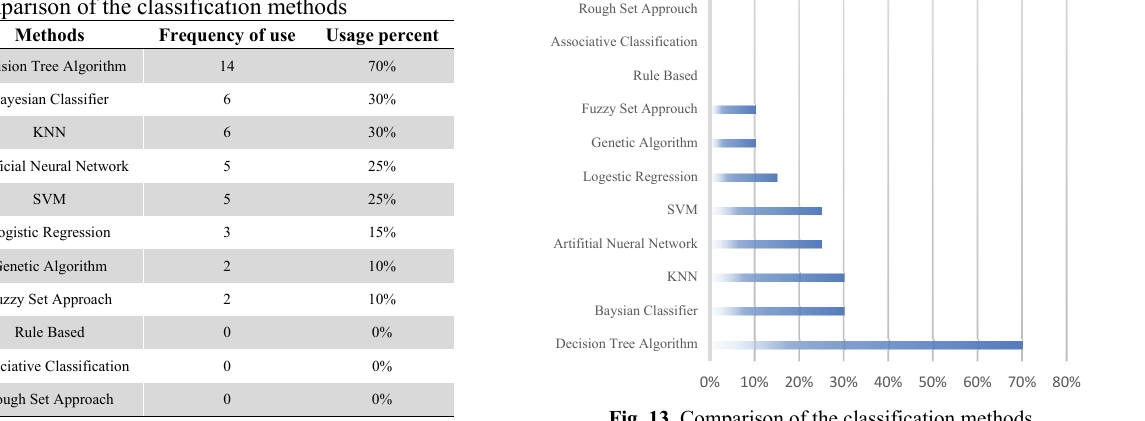
Fig. 13. Comparison of the classification methods